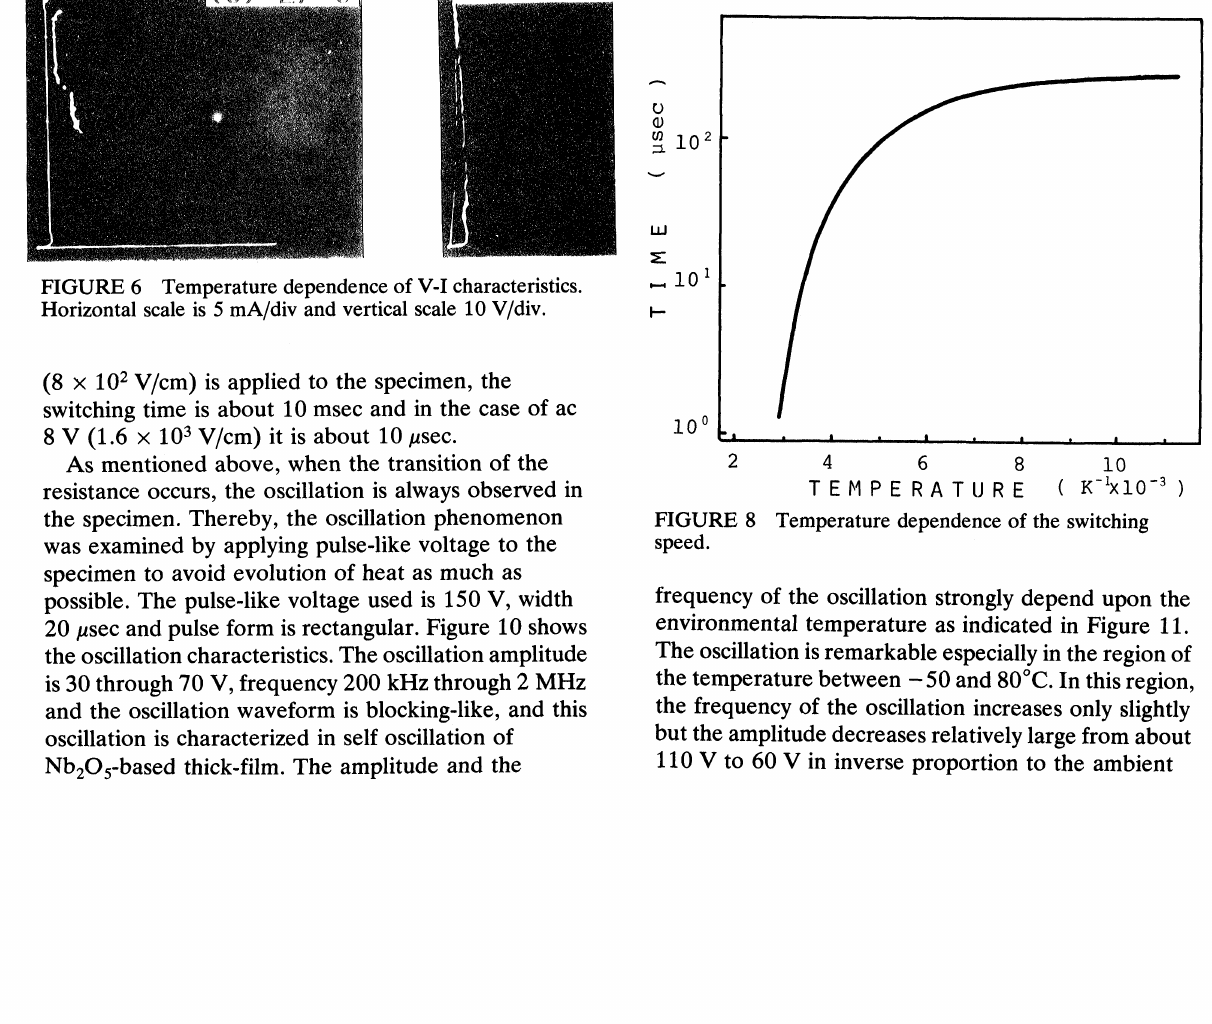
FIGURE 6 Temperature dependence of V-I characteristics. Horizontal scale is 5 mA/div and vertical scale 10 V/div. (8